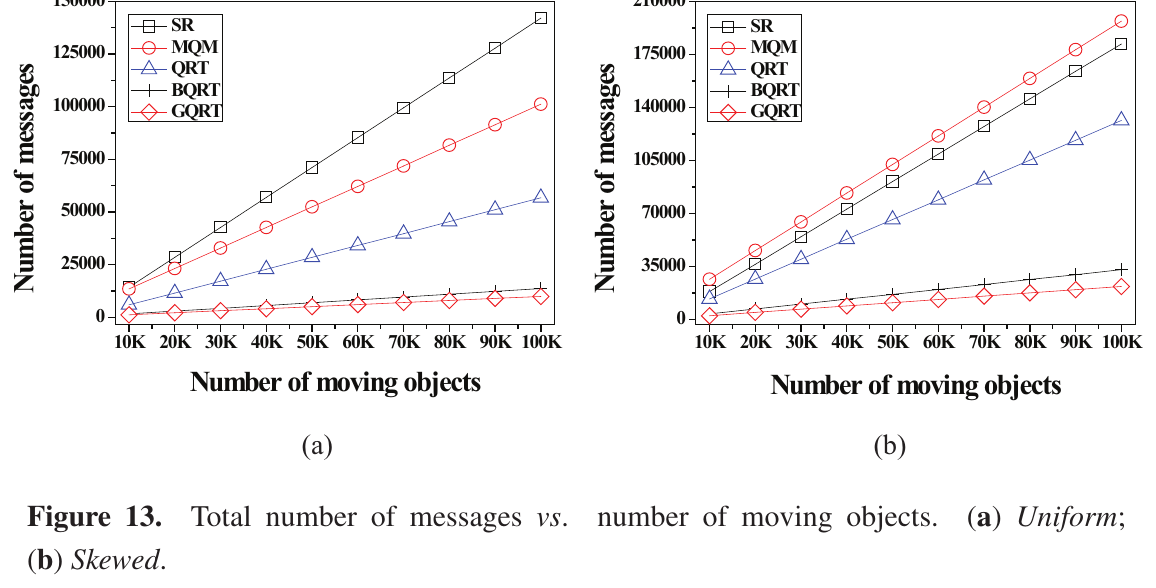
Figure 13. Total number of messages vs . number of moving objects. ( a ) Uniform ; ( b ) Skewed .